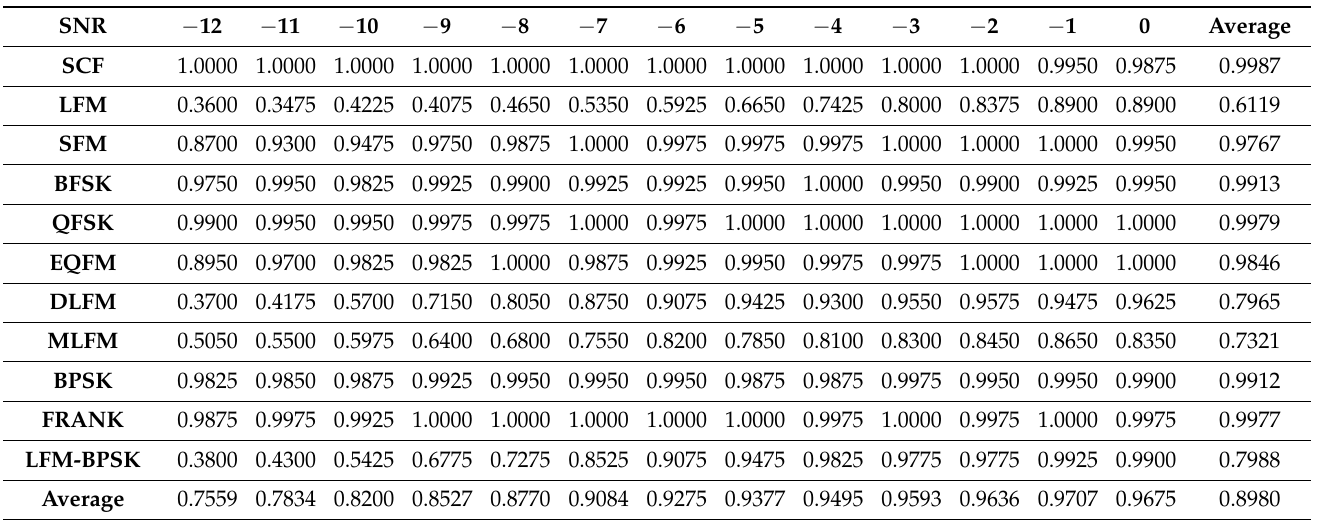
Table A29. Semi-supervised classification results of our proposed method with the datasets in Situation Dataset